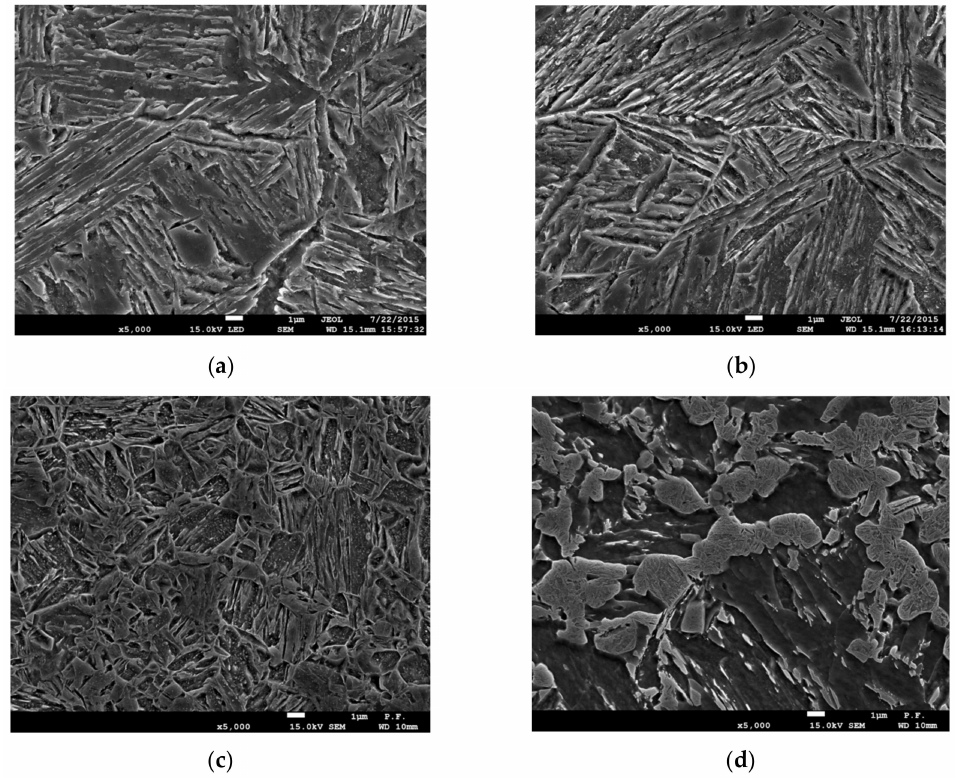
Figure 6. Microstructure in joint welded according to Q 5: ( a ) WM; ( b ) HAZ1; ( c ) HAZ2; ( d )